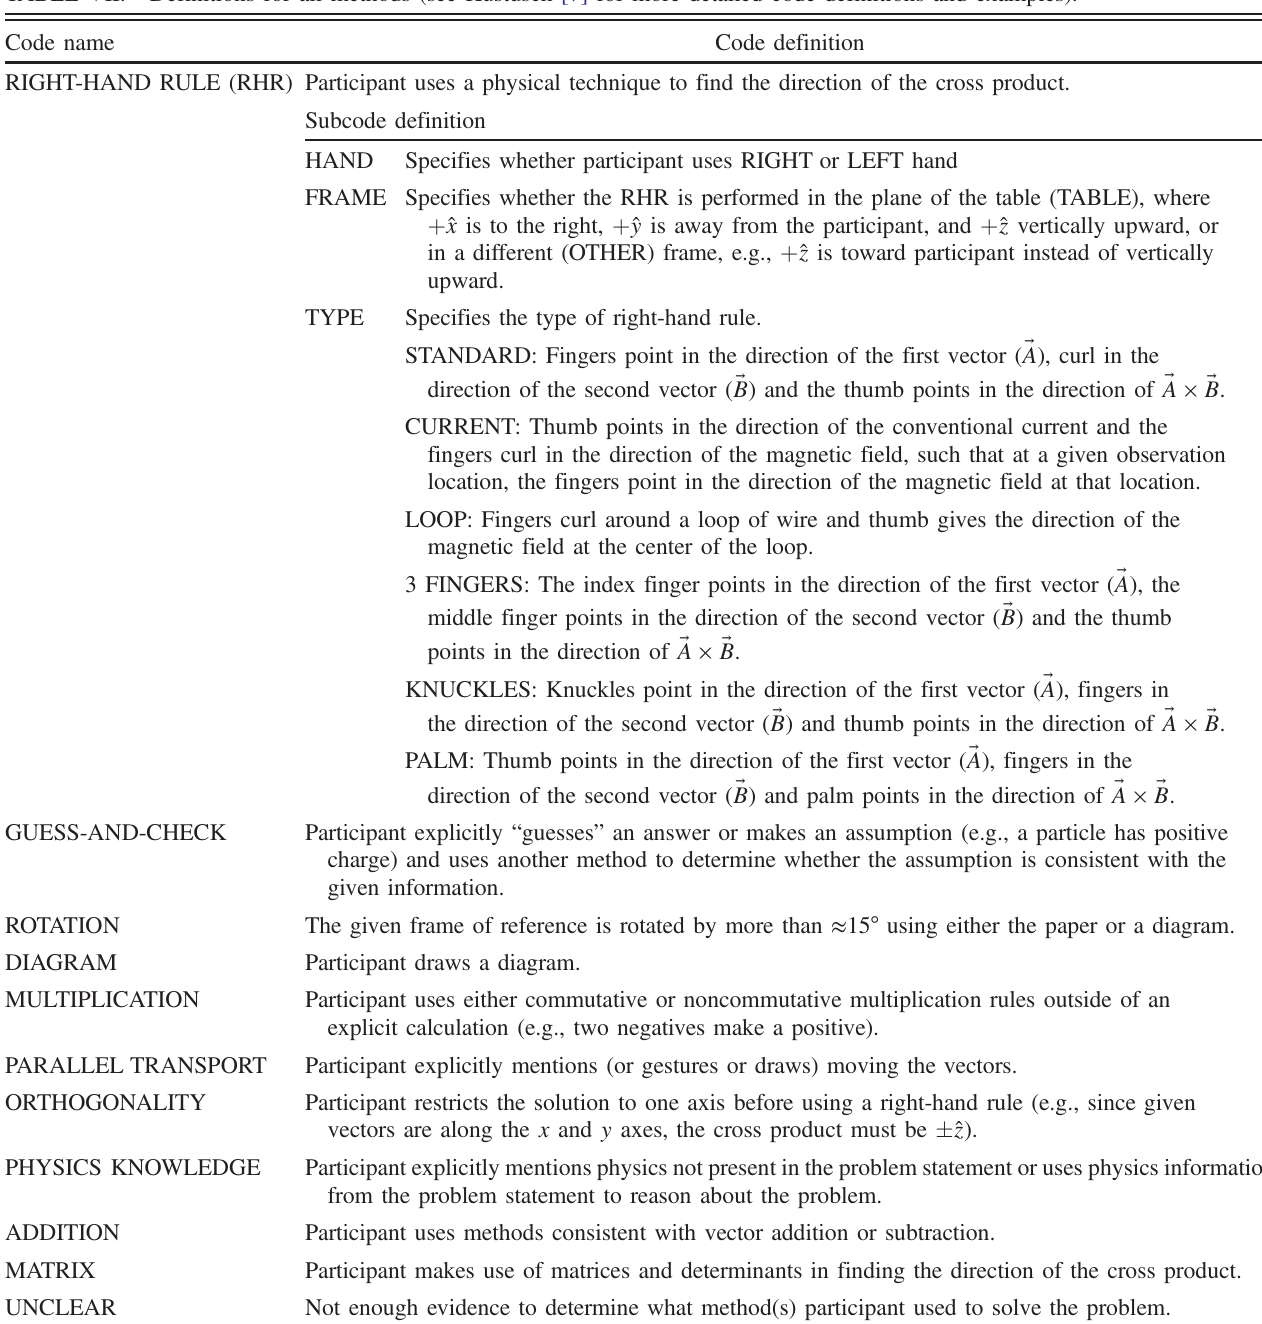
TABLE VII. Definitions for all methods (see Kustusch [7] for more detailed code definitions and examples). Code name Code definition RIGHT-HAND RULE (RHR) Participant uses a physical technique to find the direction of the cross